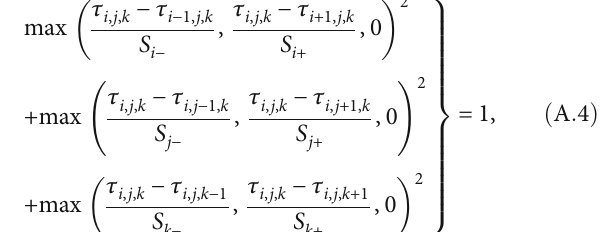
> t > t in3 in2 in1